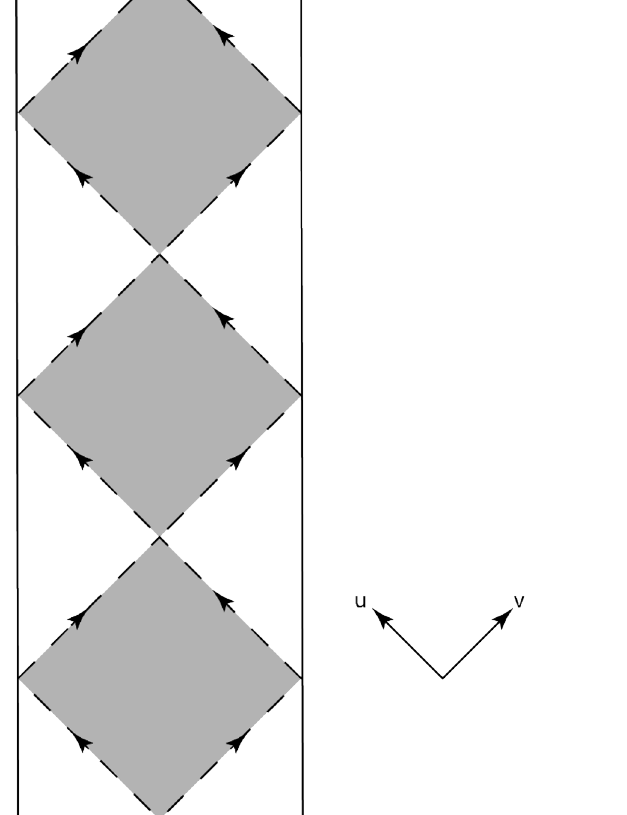
Figure 1 . Penrose diagram showing the asymptotically anti-de Sitter imploding-exploding im- pulsive waves. The grey interior region corresponds to a solution with superrotation charge. The unshaded regions correspond to the anti-de Sitter vacuum with the unperturbed metric on the